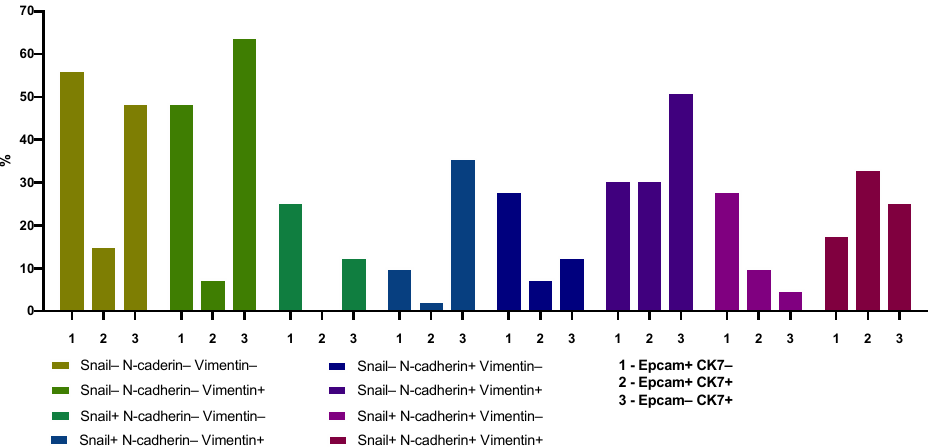
Figure 1. The frequencies of circulating tumor cells (CTCs) with co-expression of EpCAM and CK7 depending on Snail, N-cadherin and Vimentin expression in breast cancer patients.